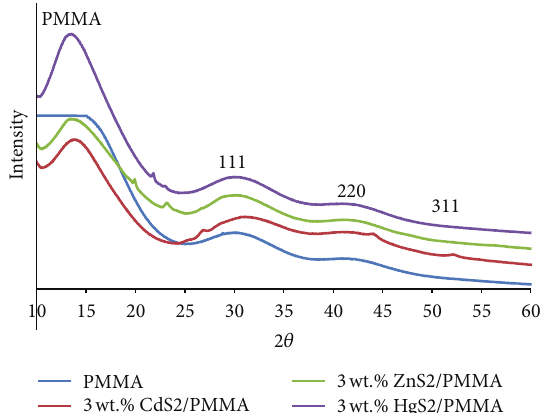
Figure 2: XRD patterns of pure PMMA, ZnS/PMMA, CdS/PMMA, and HgS/PMMA nanocomposites.